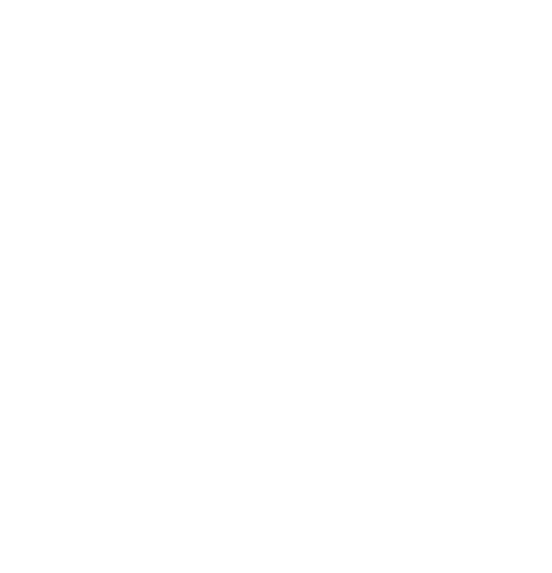
Table 2. Country-level bivariate relations with Somi across three domains. * p < .05, ** p < .01, *** p < .001.